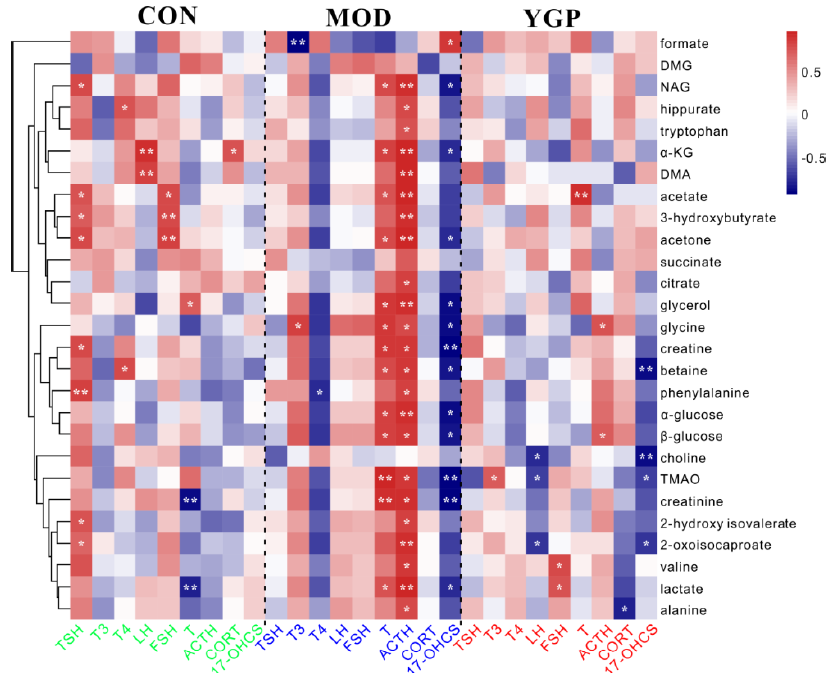
Figure 8. Pearson’s correlation analysis of 27 differential metabolites and nine biochemical parameters related to the pathogenesis axis of KYDS in the CON, MOD, and YGP groups, respectively. * p < 0.05, ** p < 0.01 (two-sided test), red indicates positive correlation, blue represents a negative correlation. 27 differential metabolites were clustered analysis by Euclidean distance.